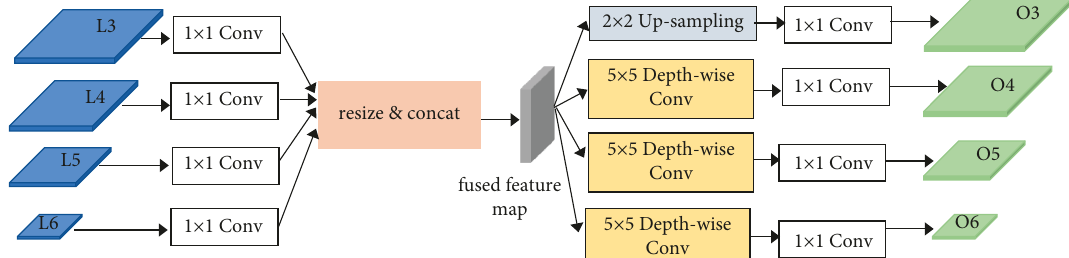
Figure 2: The structure of the proposed feature pyramid generation module.